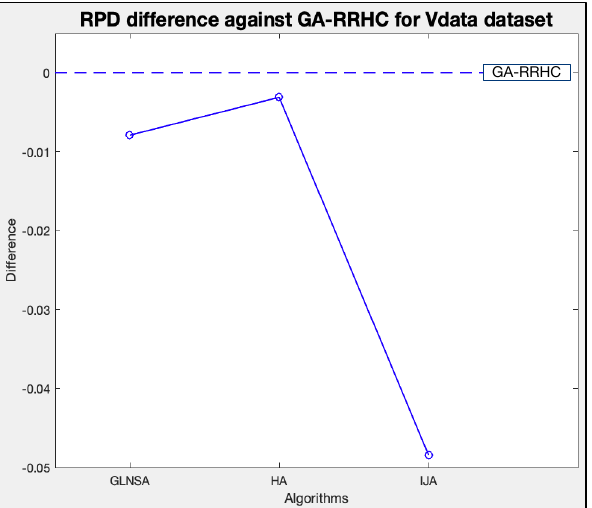
Figure 19. Comparison of the RPD difference per algorithm for the Vdata